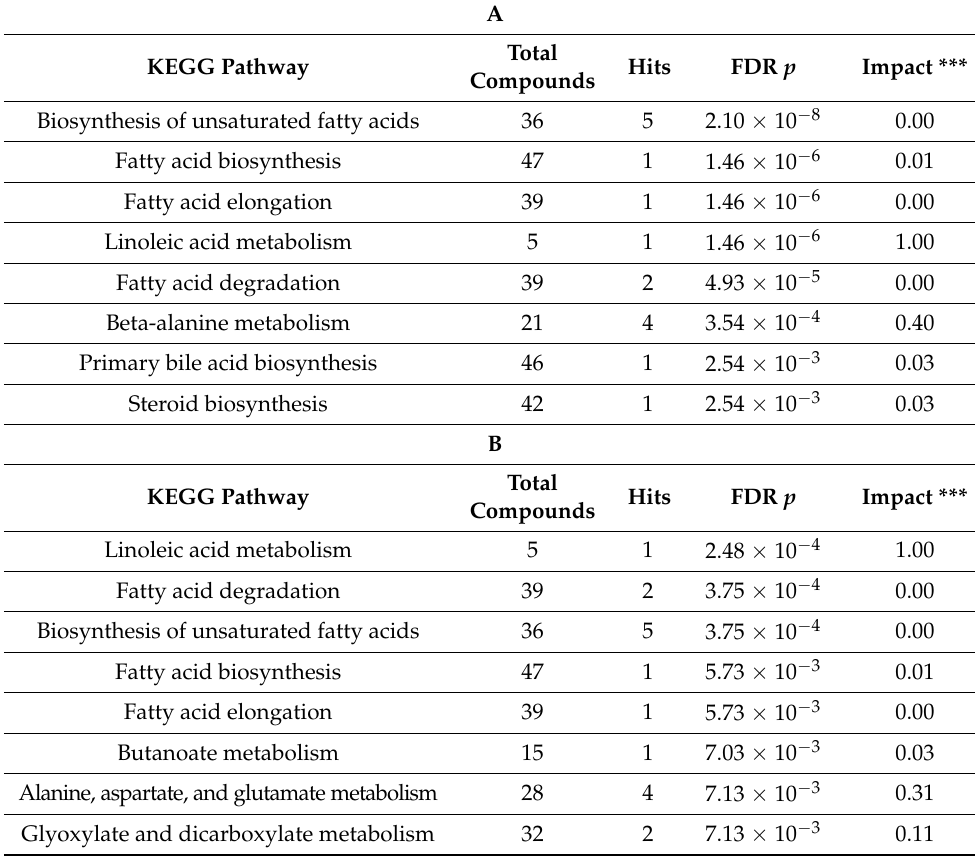
Table 2. (A): In the AIN vs HFD group, the top 8 significant metabolic pathways are involved in the 65 altered metabolites *. (B): In the HFD vs. HFD + AOM group, the top 8 significant metabolic pathways are involved in the 65 altered metabolites